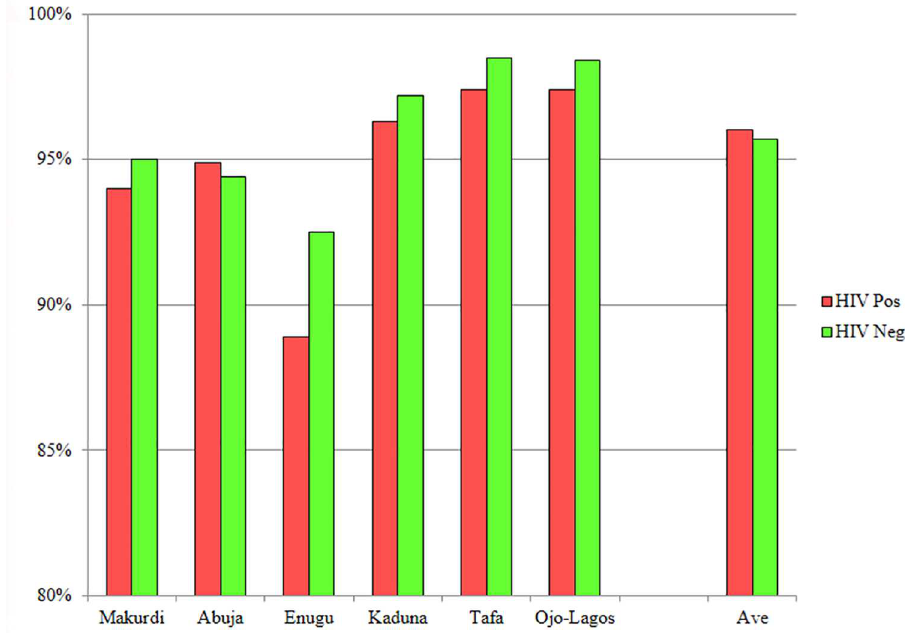
Fig 2. Willingness of volunteers to participate in future